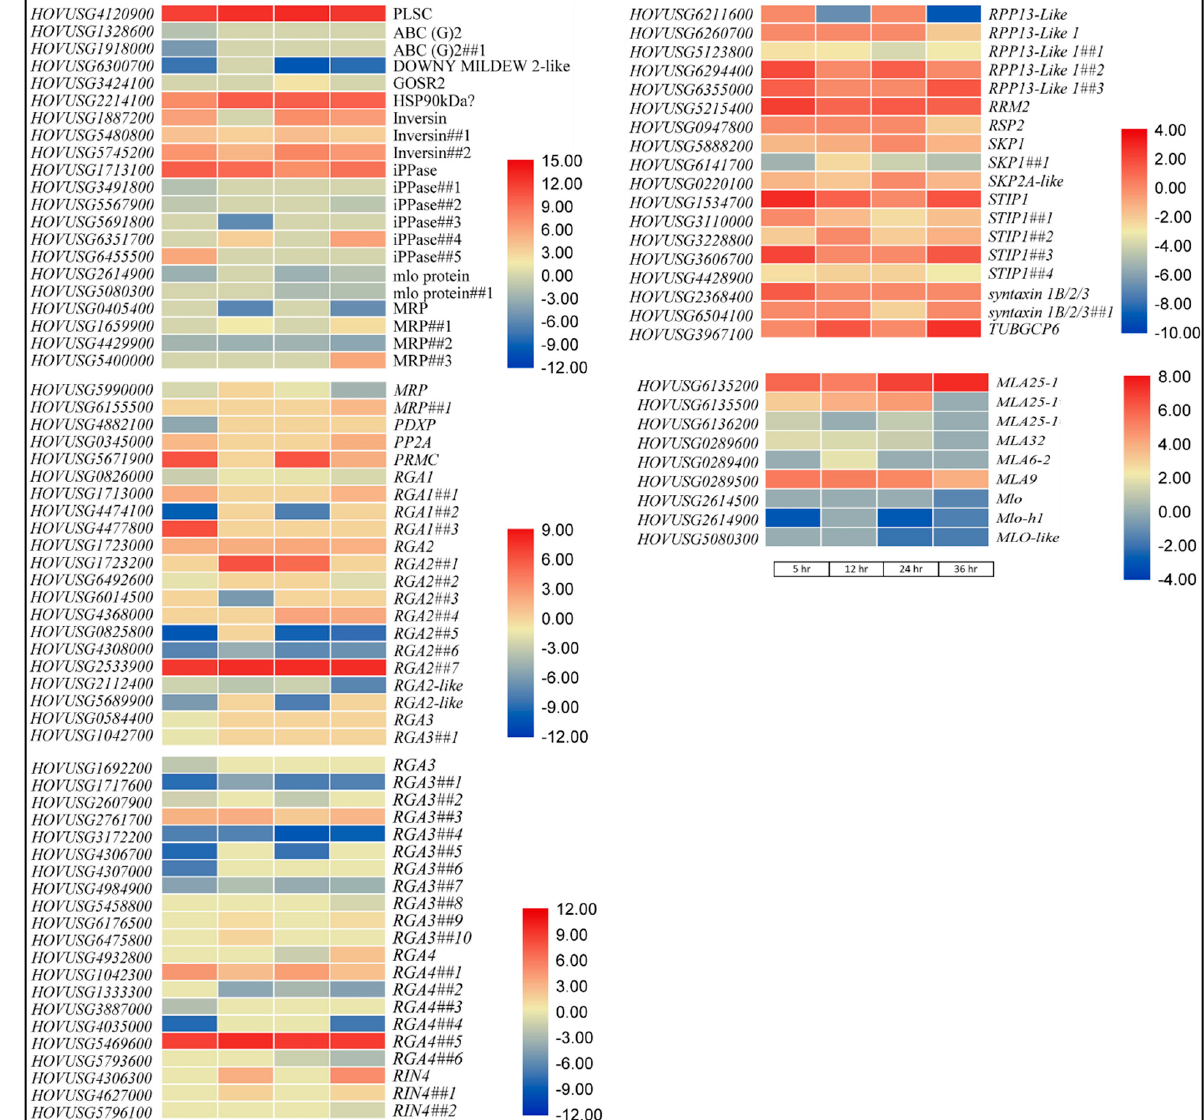
Figure 7. Heatmaps of log2 FC values of DEGs related to PM resistance that were regulated between XL19 and ZYM1288 hulless barley genotypes at 5, 12, 24, and 36 h after infection with PM.